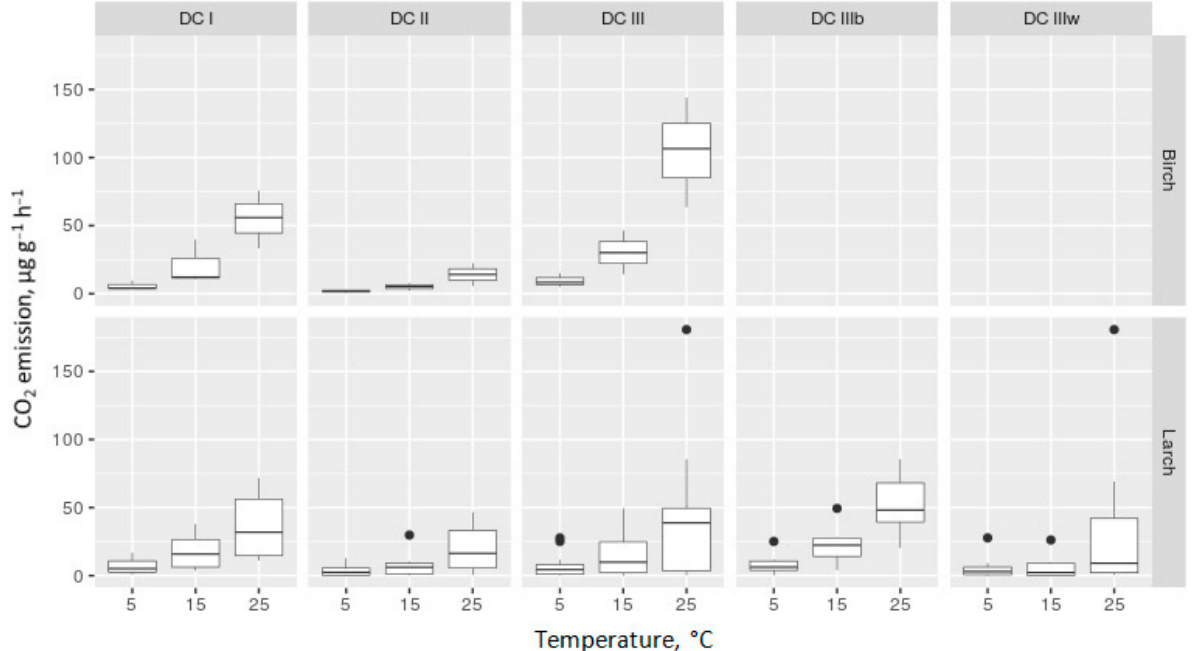
Figure 1. The rate of CO 2 emission during decomposition of larch (Larch) and birch (Birch) wood, shown as box plots (box is an interquartile range (from 25th percentile to 75th percentile), horizontal line is a median value, vertical lines are a range between minimum and maximum values, dots are an outliers): DC I–DC III—decomposition classes I–III; DC IIIw—separately, larch wood of DC III decomposed by white rot fungi; DC IIIb—separately, larch wood of DC III decomposed by brown rot.